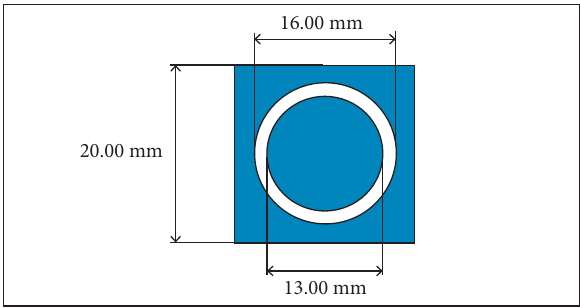
Figure 1. FSS unit cell and main